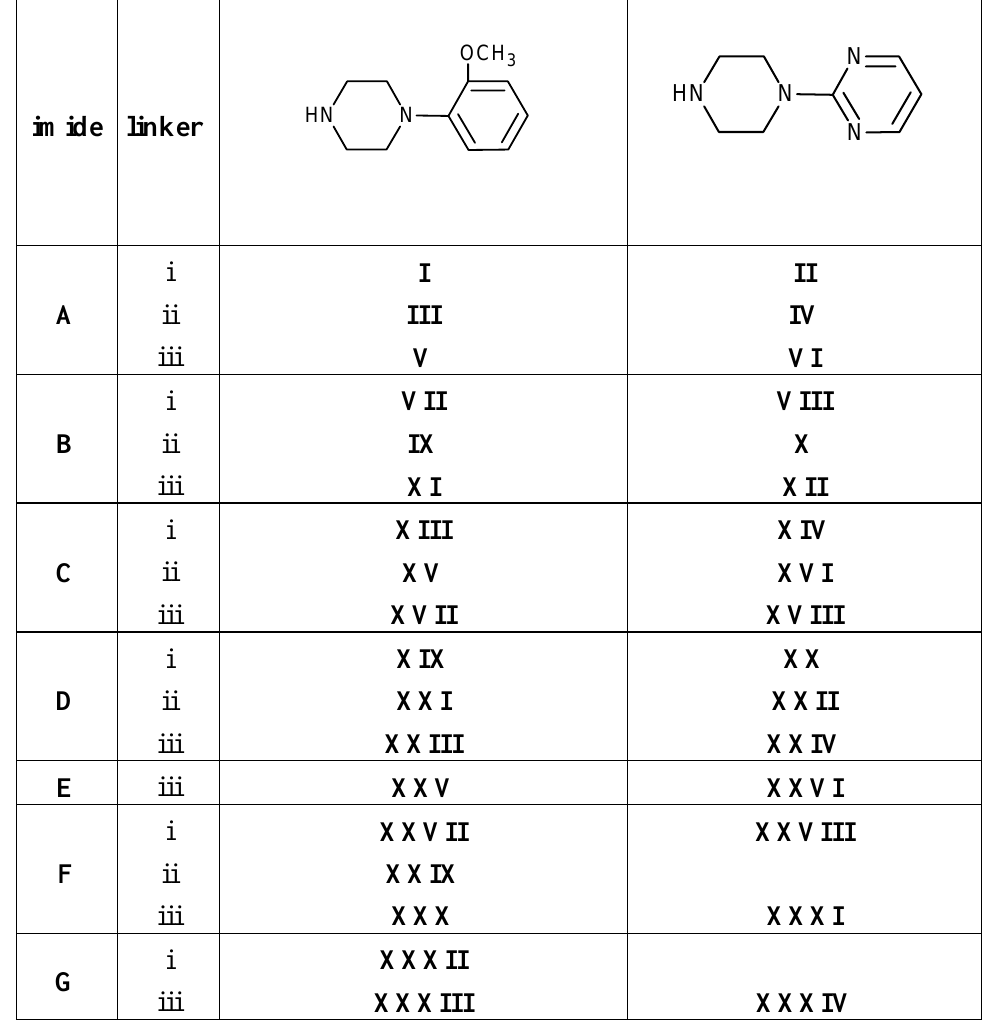
Table 1 . Numbering of derivatives obtained in the described